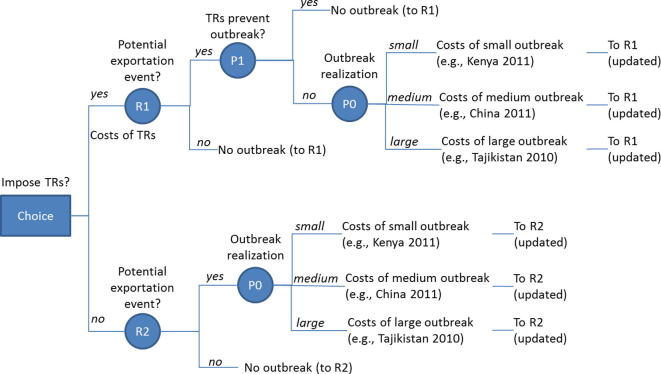
Decision tree for the choice to issue temporary recommendations (TRs) for serotype 1 wild poliovirus (WPV1). Circles with a P indicate one-time probabilities of different outcomes, while circles with R indicate probabilities that apply at each time step and may change with time as new WPV1 outbreaks may occur.